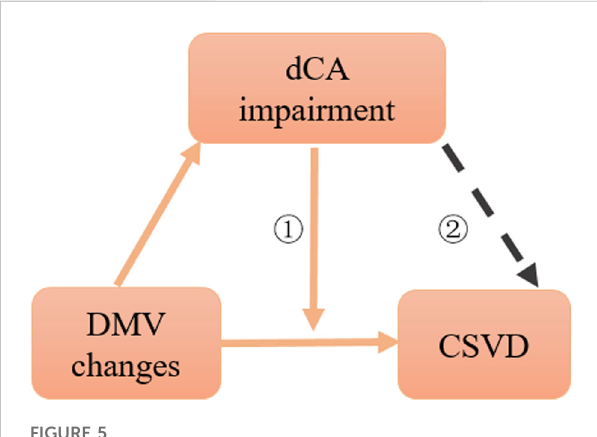
FIGURE 5 Schematic diagram of association among dCA, DMV changes, and CSVD. ① : interaction effect, ② : citation from CNS Neurosci Ther. 2022; 28:298 –